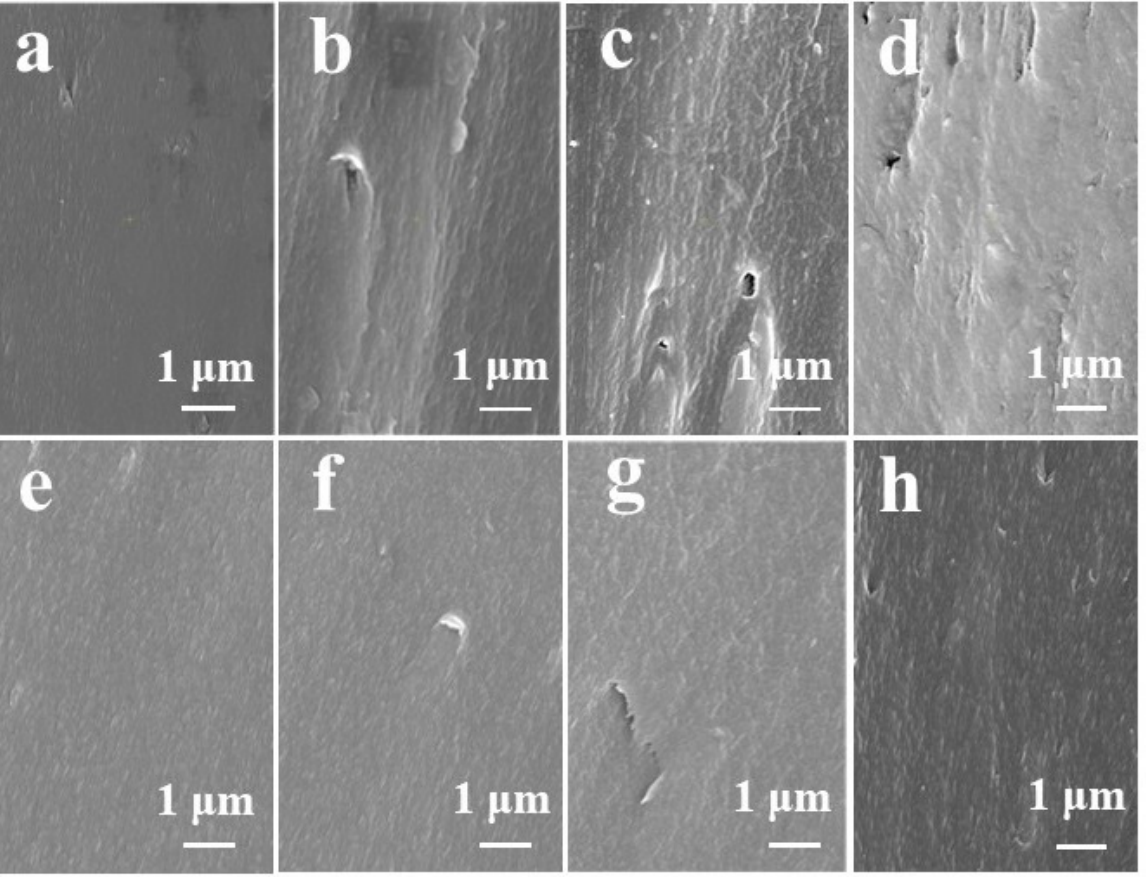
Figure 2. SEM images of the fractured surface for PI composites with ( a ) 0.25 wt%, ( b ) 0.5 wt%, ( c ) 0.75 wt% and ( d ) 1.0 wt% CNNS and ( e ) 0.25 wt%, (f) 0.5 wt%, ( g ) 0.75 wt% and ( h ) 1.0 wt% DCNNS.